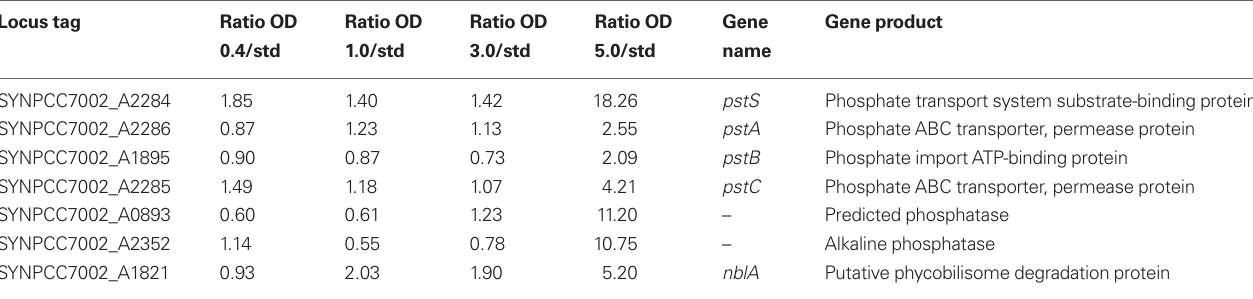
Table 4 | Prominent changes in transcript levels at different culture densities of a batch culture. Locus